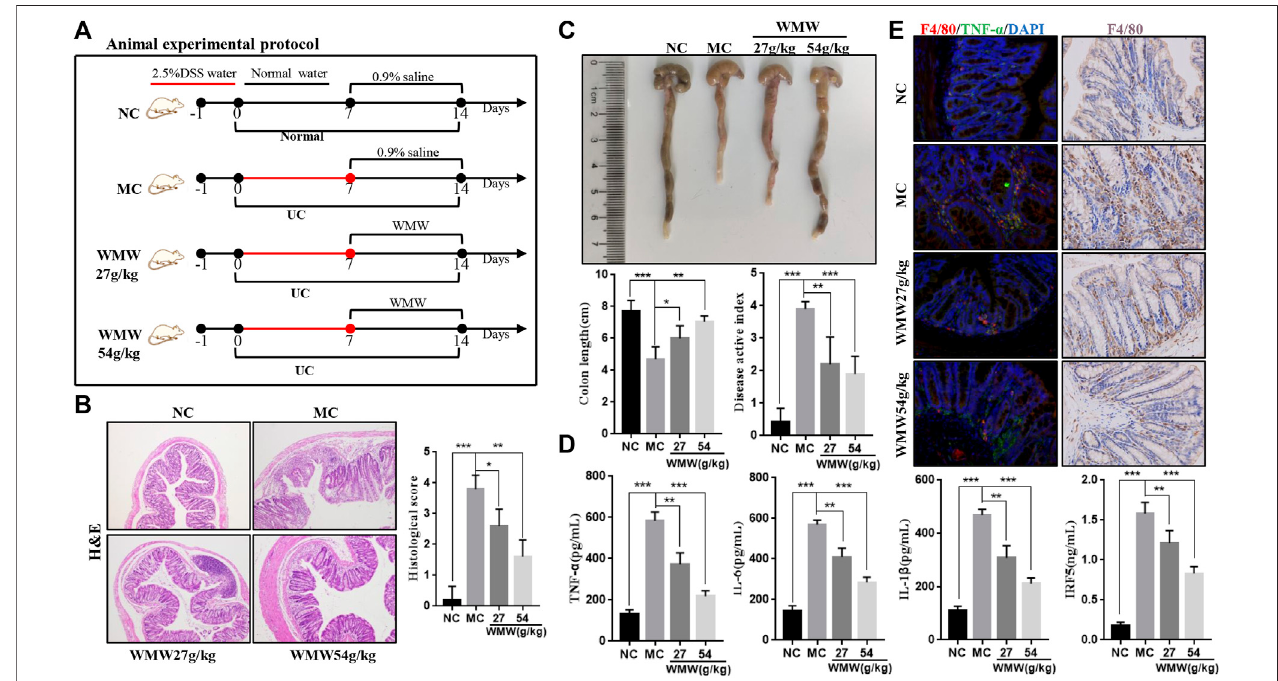
FIGURE 2 | Effect of WMW on DSS-induced acute colitis in mice. (A) Scheme of experimental procedure for C57BL/6 mice were given drinking water containing 2.5% DSS for 1 week followed by oral administrated with WMW (27 g/kg, 54 g/kg) for 1 week. (B) Representative colon H&E staining and the histological score at different groups (original magni fi cation, 100 ×). (C) Representative colon images and the length of different groups. DAI of mice was recorded weekly during the experiment. (D) Expression of TNF- α ,IL-1, IL-6 and IRF5 in colon tissue were determined by ELISA from DSS-challenged mice (E) Double immuno fl uorescent signalsfromF4/80andTNF- α ,F4/80ImmunohistochemistryinDSS-inducedcolitistissueatdifferentgroups(originalmagni fi cation,400×). n =7 – 10,means±SEM.* p < 0.05, ** p < 0.01,*** p < 0.001.